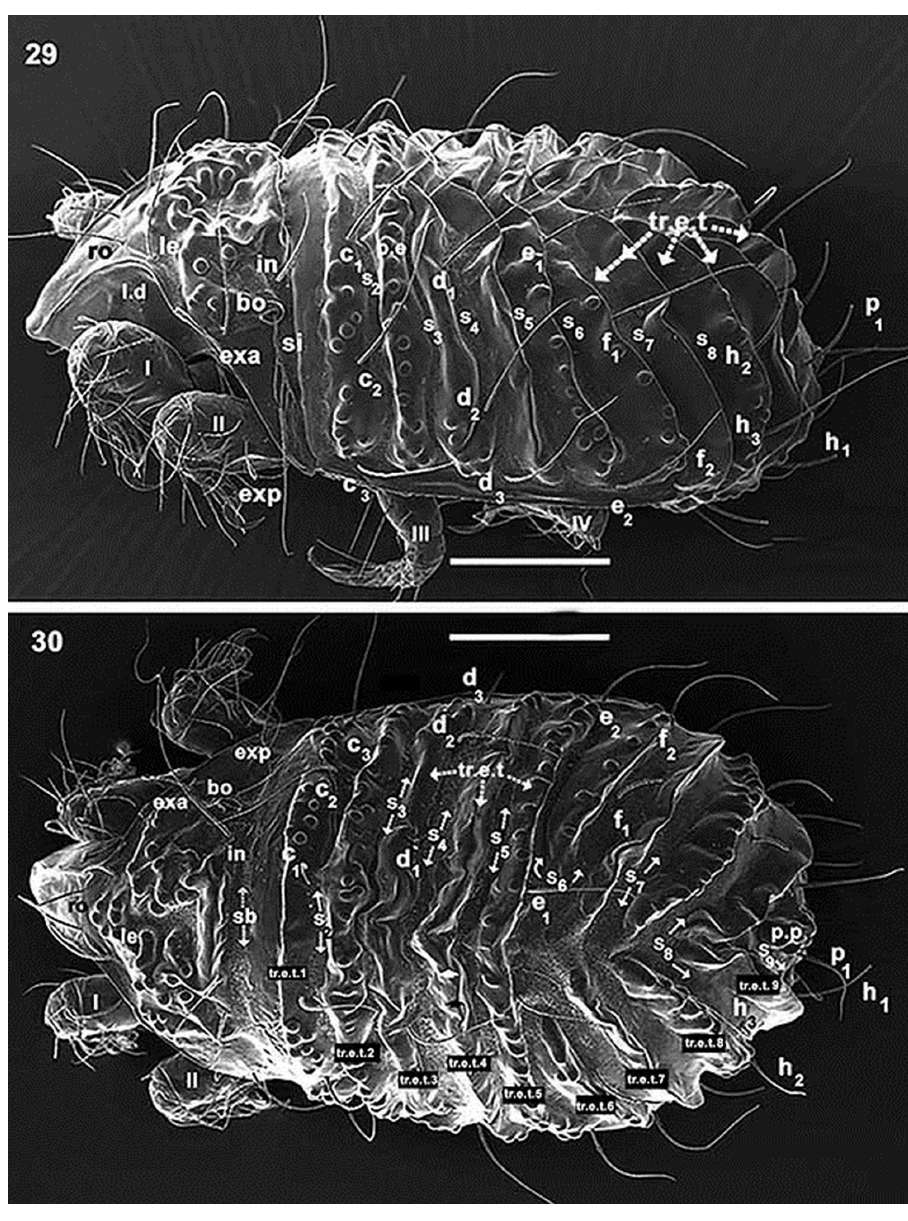
Figures 29–30. Paulianacarus costaricensis sp. n. Adult with cerotegumental layer. SEM. 29 lateral inclined view 30 dorsal with slight lateral tilt. Abbreviations: See Material and methods. Scale bars: 29, 30 = 200